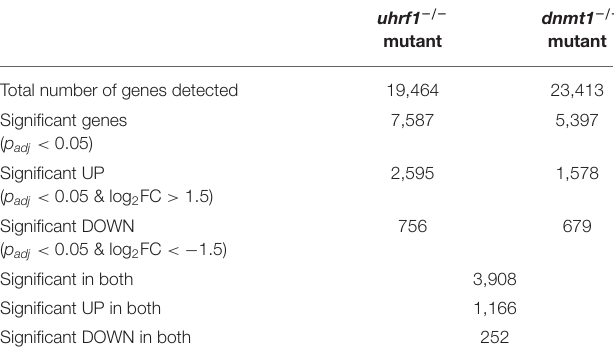
TABLE 3 | RNAseq analysis of uhrf1 and dnmt1 mutant livers at 5